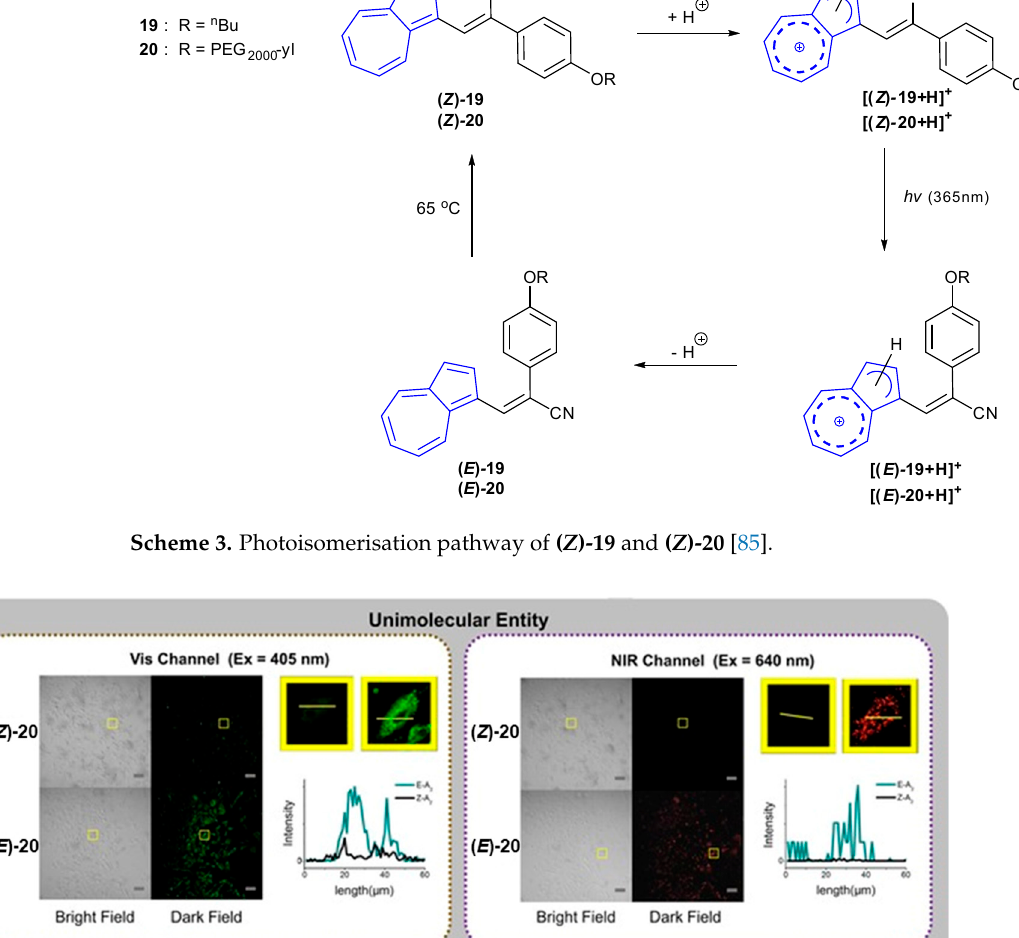
Figure 17. Selective cell imaging of ( Z )-20 and ( E )-20 in either the visible or NIR region in MC3T3-E1 cells. Reproduced with permission from ref. [85]. Copyright 2017 Wiley–VCH Ver-